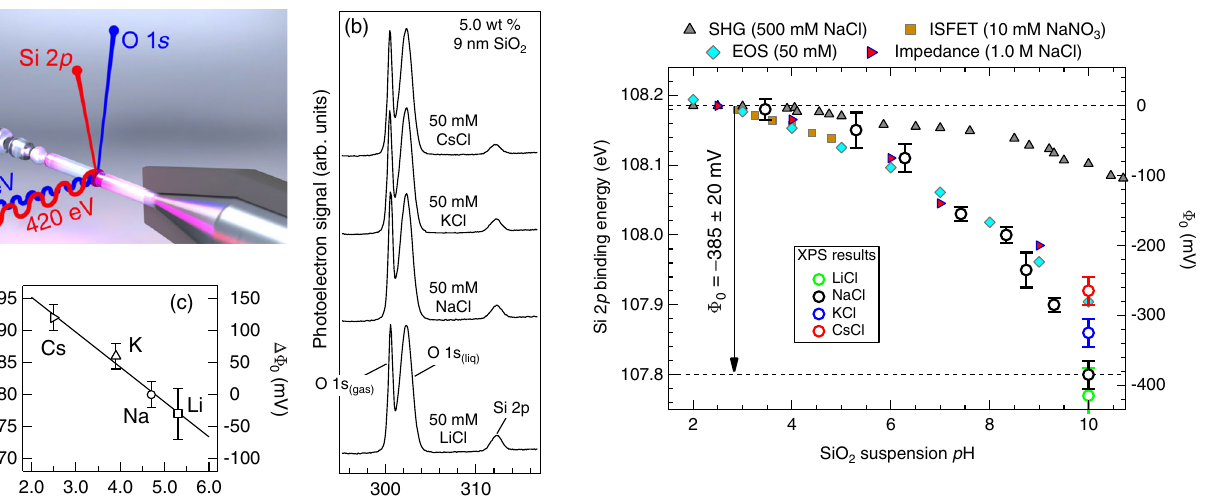
FIG. 3. p H-dependent absolute surface potential at the silica- electrolyte interface. Si 2 p binding energy (left-hand axis) and absolute surface potential (right-hand axis) at the water-silica interface for 9-nm SiO 2 in 50-mM NaCl electrolyte (open black markers) as a function of bulk suspension p H. Open markers: Surface potentials at p H 10.0 in 50-mM LiCl (green), KCl (blue), and CsCl (red). Error bars represent the standard deviation of two measurements (four at p H 10.0). Solid markers: Surface potentials for various extended SiO 2 surfaces as reported in the literature: SHG [38], ISFET [39], EOS [40], and Impedance [41]. compared to that at p H 10. Our measurements reveal the absolute surface potential of 9-nm SiO 2 at p H 10.0 in 50-mM NaCl electrolyte to be − 385 (cid:2) 20 mV. The absolute surface potentials for the other alkali chloride electrolytes follow directly from their measured Δ Φ 0 (Table II, open markers in Fig. 3 at p H 10.0). The overall shape of the Φ 0 ð p H Þ response measured by XPS is consistent with several earlier studies that report the measurement of surface potentials for extended silica